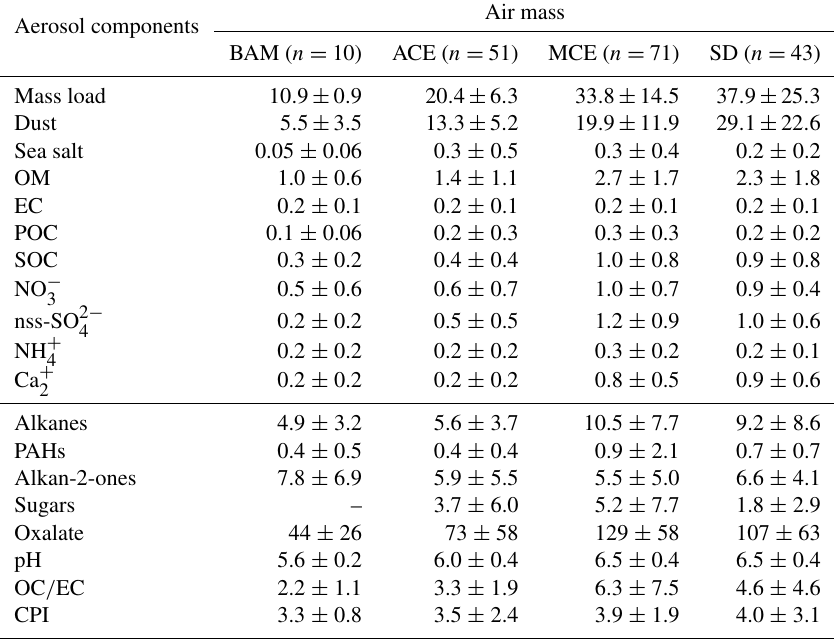
Table 4. Concentrations of main aerosol chemical species in PM 10 according to each air mass (µgm − 3 ) at AMV; the number of samples is written in parentheses. The organic compositions including alkanes, PAHs, alkan-2-ones, sugars, and oxalate are given in units of ngm − 3